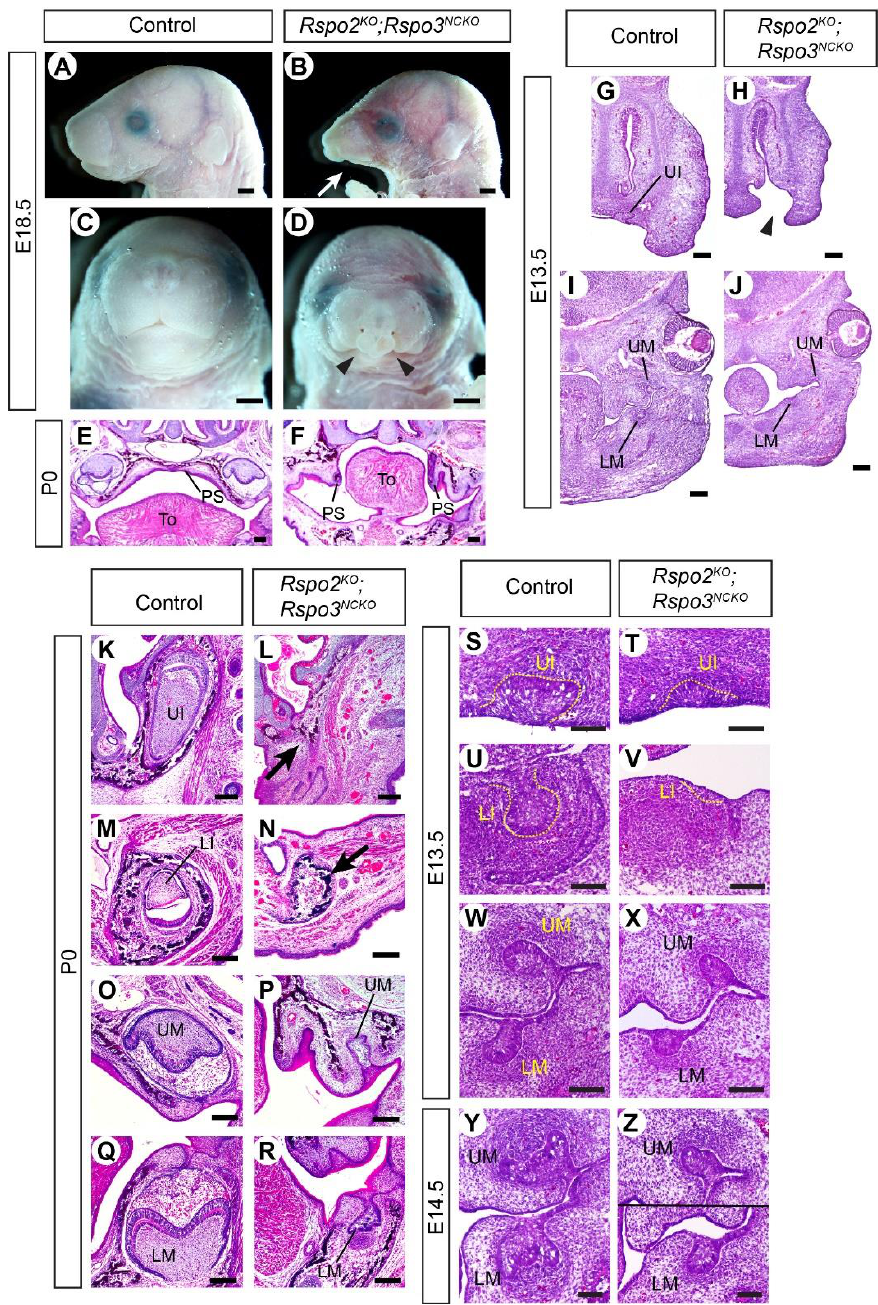
Figure 3. Craniofacial and dental phenotypes of Rspo2 KO ;Rspo3 NCKO mutants. ( A – D ) Lateral ( A , B ) and frontal ( C , D ) views of the head. 15 animals were examined (11 controls and 4 mutants). The arrow in ( B ) points to the hypoplasia of the mandible. Arrowheads in ( D ) point to the cleft lip. ( E – Z ) Coronal sections of the head stained with hematoxylin and eosin. A total of 6 animals were examined at each stage (3 controls and 3 mutants). The arrowhead in ( H ) points to the cleft lip. Arrows in ( L , N ) indicate the absence of the incisors. PS: palatal shelves, To: tongue. Bars in ( A – D ): 1 mm; bars in ( E – J ): 0.2 mm; bars in ( K – Z ): 0.1 mm. Genotypes of the controls shown are Rspo2 +/ − ;Rspo3 fl/+ ( A , C , E , M ), Rspo3 fl/+ ( G , I ), Rspo3 fl/ − ( K , O , Q ), Wnt1-Cre;Rspo3 fl/+ ( S , U , W ), and Wnt1-Cre;Rspo2 +/ − ;Rspo3 fl/+ ( Y ).